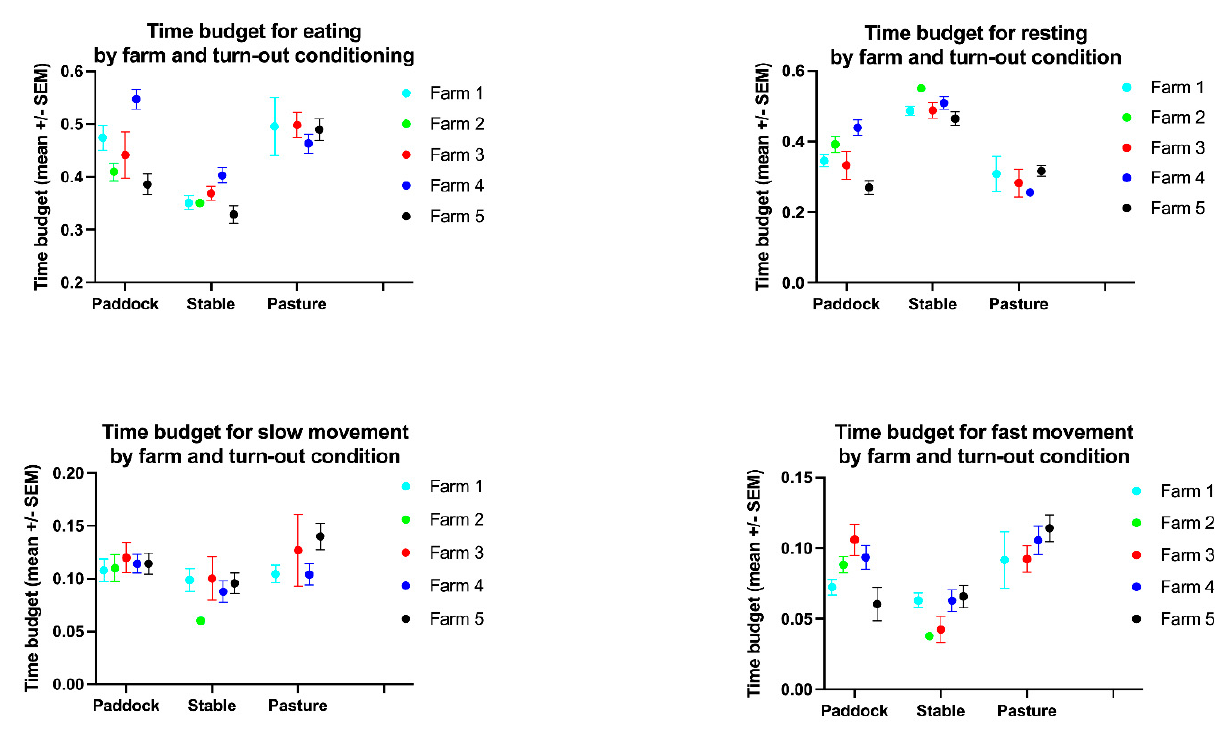
Figure 3. Time budgets for eating, resting, slow movement (“active”) and fast movement (“highly active”) by farm and turn-out condition.